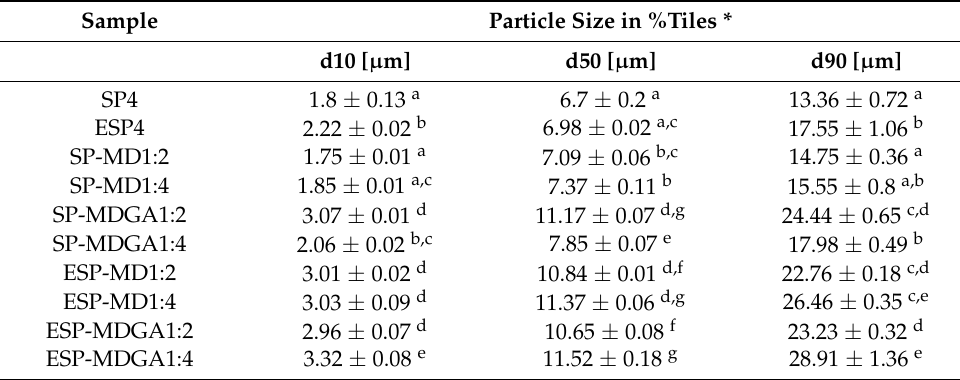
Table 3. Particle size distribution of microencapsulated Arthrospira platensis